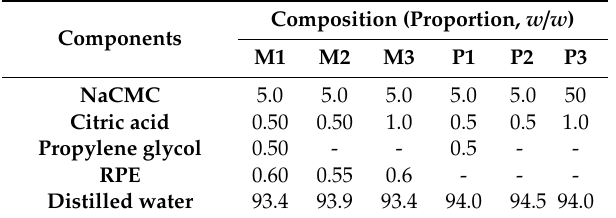
Table 2. Compositions of membranes (M1, M2 and M3), loaded with red propolis extract (RPE). Composition (Proportion, w / w Components